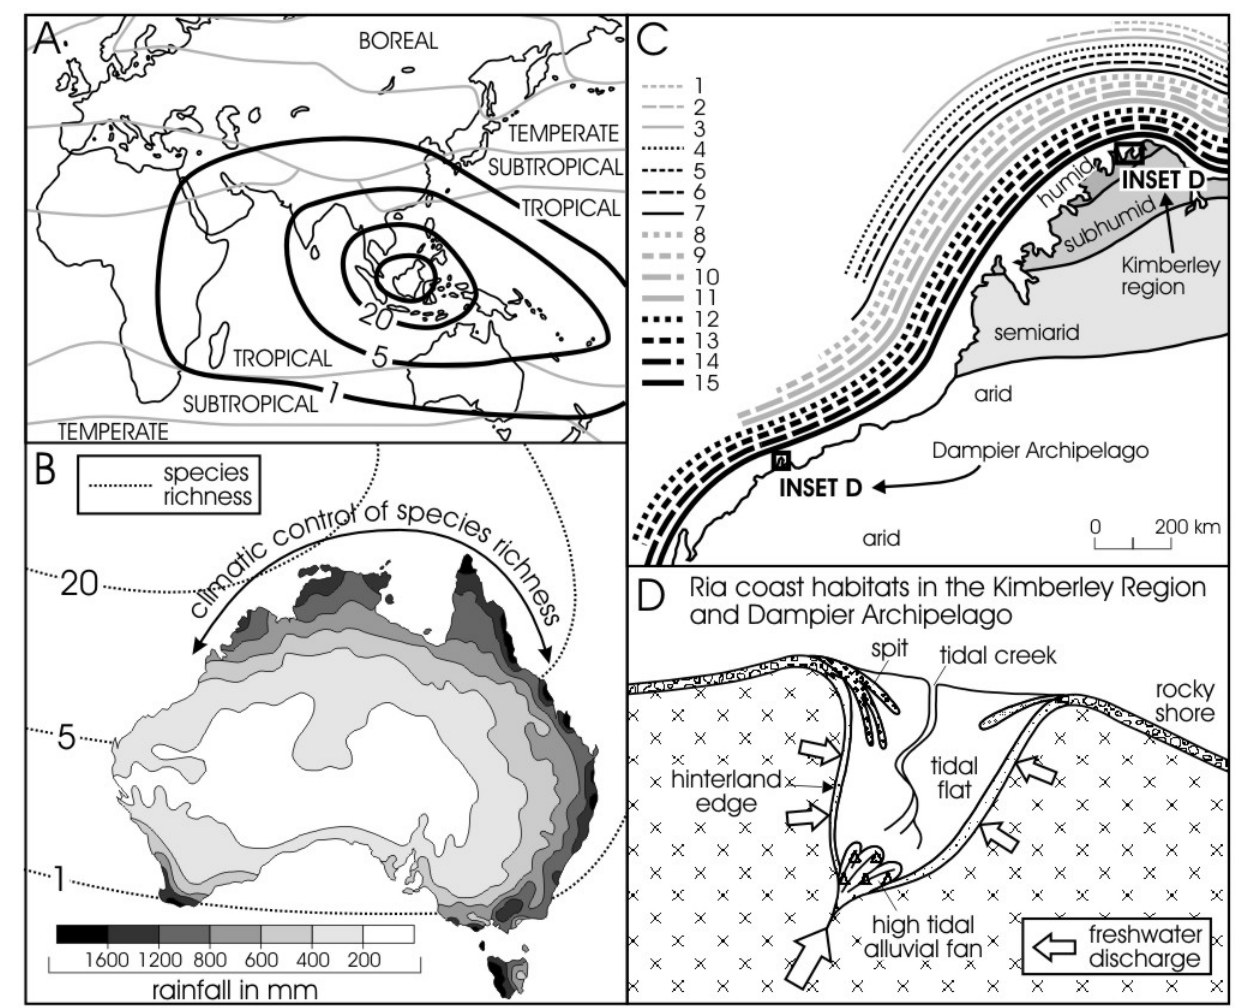
Figure 4. Mangroves in the Kimberley Region and Dampier Archipelago of Northwestern Australia. From a regional species pool involving ~20 mangrove species (Insets A & B ), there is progressive decrease in the species richness correlated with climate (Inset C ); each line parallel to the coast shows the biogeographic distribution of the 15 mangrove species in the Kimberley Region and the six mangrove species in the Dampier Archipelago [Key to numeration of species: 1. Scyphiphora hydrophylacea , 2. Xylocarpus granatum , 3. Bruguiera parviflora , 4. Camptostemon schultzii , 5. Lumnitzera racemosa , 6. Xylocarpus moluccensis , 7. Sonneratia alba , 8. Excoecaria agallocha , 9. Osbornia octodonta , 10. Aegiceras corniculatum , 11. Bruguiera exaristata , 12. Ceriops tagal , 13. Aegialitis annulata , 14. Rhizophora stylosa , 15. Avicennia marina ]. Inset D whose geographic locations are shown in ( C ) for the Kimberley Region and Dampier Archipelago illustrates the range of habitats in these ria coasts. The species richness and structure of the mangrove vegetation in these six habitats of ria coasts is described in [26] and